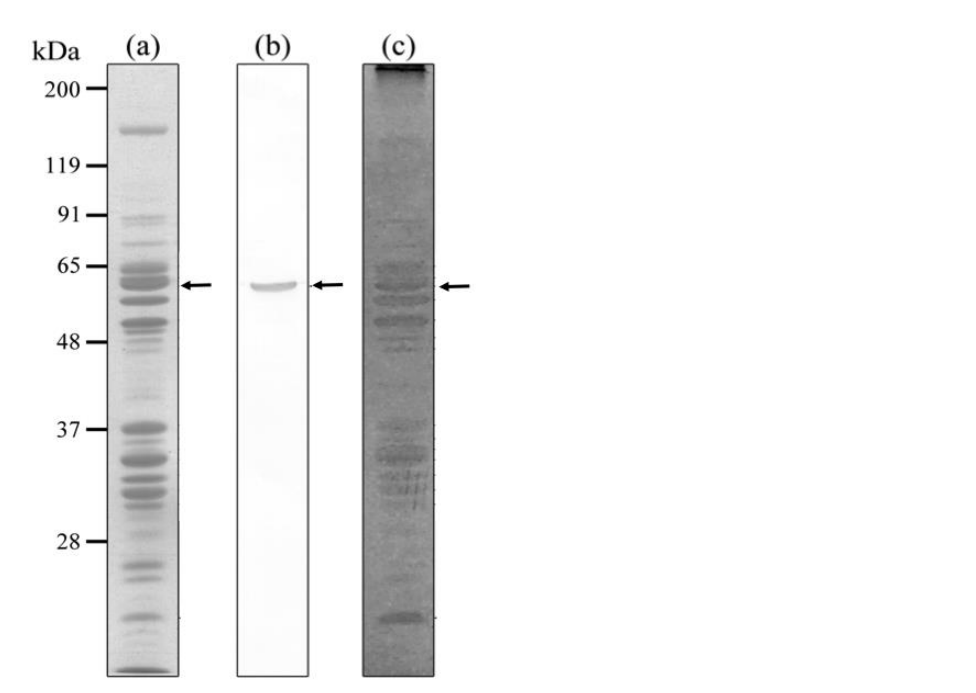
Figure 5. SDS-DNA PAGE of IF cells of H. obtusa . P. caudatum DNA was used. ( a ) CBB stained gel. ( b ) Immunoblot with mAb3D1B9C4 specific for PRP1. ( c ) EB stained gel. Arrows, 63-kDa PRP1. It should be noted that not only PRP1 but also many EB-negative bands that show the positions of DNA-protein complexes appeared (see Materials and Methods section).